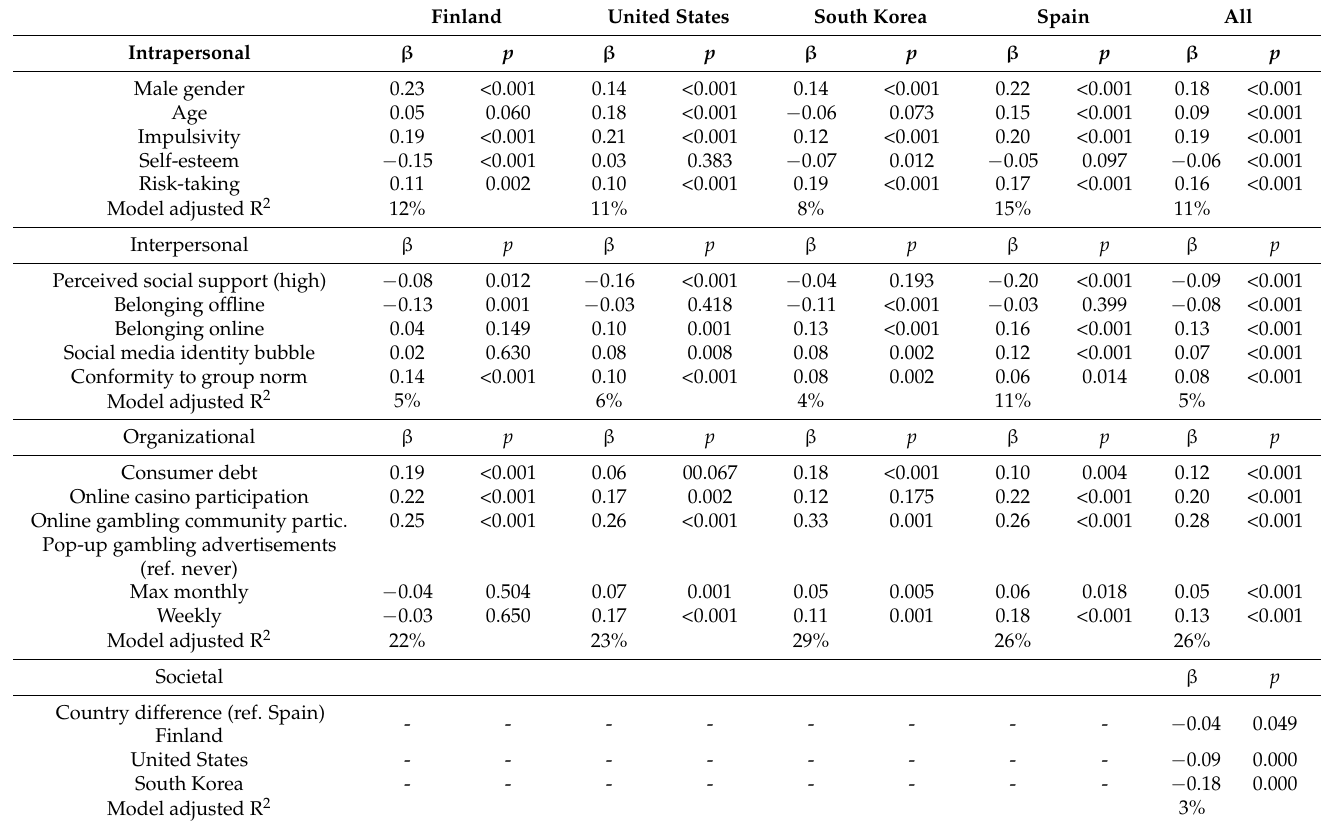
Table 2. Problem gambling explained by intrapersonal, interpersonal, organizational, and societal spheres in separate linear regression models. Finland United States South Korea Spain